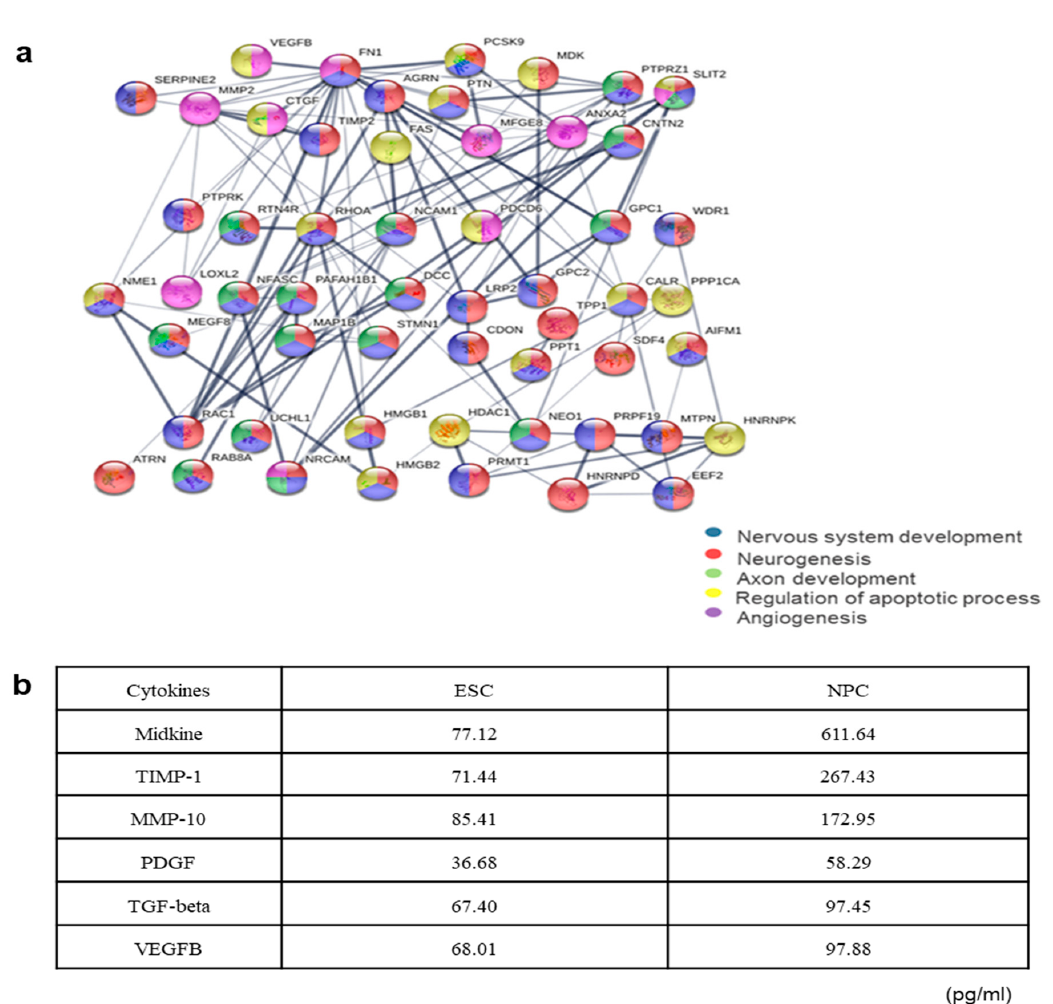
Figure 5. Qualitative analyses of the proteomics findings for NPC-CM. ( a ) Proteome networks showing predicted functional linkages among the identified proteins. STRING analysis showing the protein–protein interactions and biological processes associated with the 53 proteins secreted by NPC. ( b ) Relative levels of key cytokines in hESC-CM and hESC-derived NPC-CM after measurement by a cytokine antibody array ( n = 3 per group). Conditioned media from hESCs and NPCs were analyzed using a cytokine antibody array, and the relative cytokine levels were measured by quantification of positive pixels for each selected cytokine: midkine; TIMP-1, metallopeptidase inhibitor 1; MMP-10, matrix metalloproteinase-10; PDGF: platelet-derived growth factor; VEGF-B: vascu- lar endothelial growth factor B; TGF-beta: transforming growth factor beta; BDNF: brain-derived neurotrophic